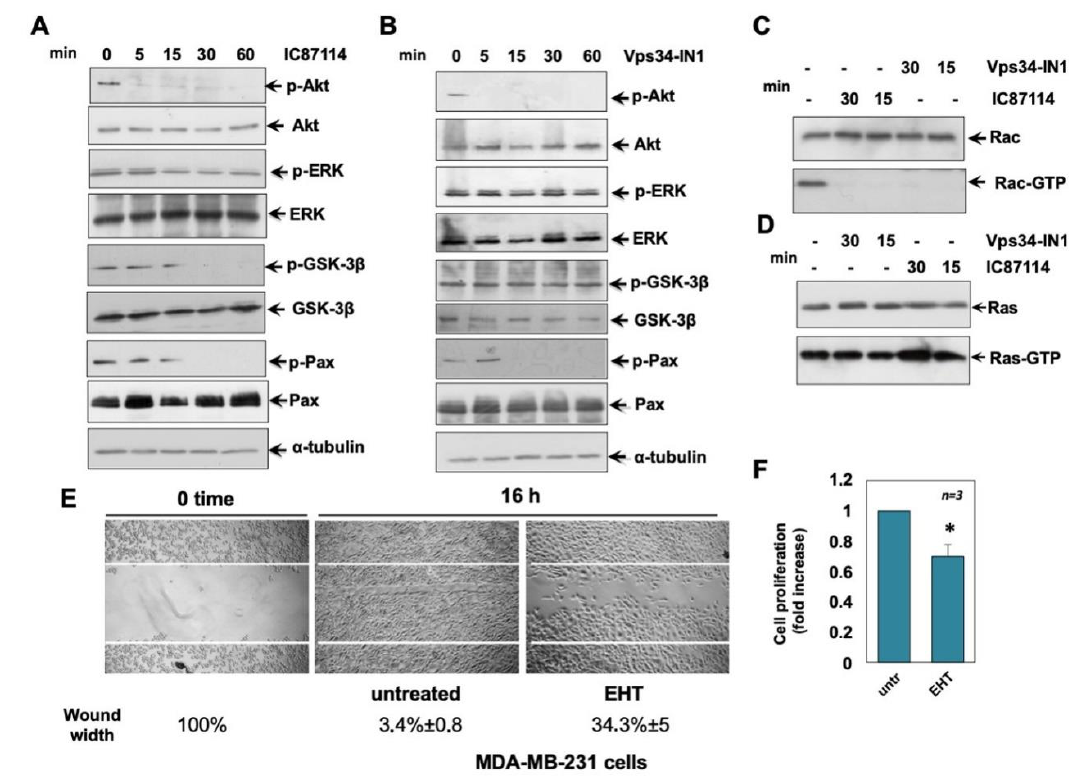
Figure 6. Effects of IC87114 and Vps34-IN1 on MDA-MB-231 cell signalling pathways. MDA-MB-231 cells were untreated or treated for the indicated times with IC87114 ( A ) or Vsp34-IN1 ( B ), and protein lysates were analysed by western blot, using the indicated antibodies against p-Akt (p-Ser-473 Akt), p-ERK (P-Tyr 204 ERK 1 and the corresponding phosphorylated ERK 2), p-GSK-3 β (p-Ser-9 GSK-3 β ), and p-Pax (P-Tyr 118 Pax). The filters were re-probed using anti-ERK, anti-Akt, anti- GSK3- β , anti- Pax, or anti- α -tubulin antibodies, as loading controls. In C and D, MDA-MB-231 cells were untreated or treated with IC87114 and Vsp34-IN1 inhibitors for 30 and 15 min, and Rac ( C ) and Ras ( D ) pull down assays were performed. Active (Rac-GTP) or total Rac (Rac) in C and active (Ras-GTP) or total Ras in D were detected by western blot. Western blots ( A – D ) are representative of three different experiments. ( E ) Cell monolayers were wounded, and untreated or treated for 16 h with the indicated compounds. Phase-contrast images are representative of three different experiments. The wound area was measured using Image J Software, and data are presented as residual % in wound width over the control (0 time) below the corresponding photographs. ( F ) Cell proliferation was analysed by WST-1, and data represented as fold change over the basal level (untreated cells). Means and SEM are shown. ( E , F ) EHT stands for EHT 1864. * p < 0.05, as compared to untreated